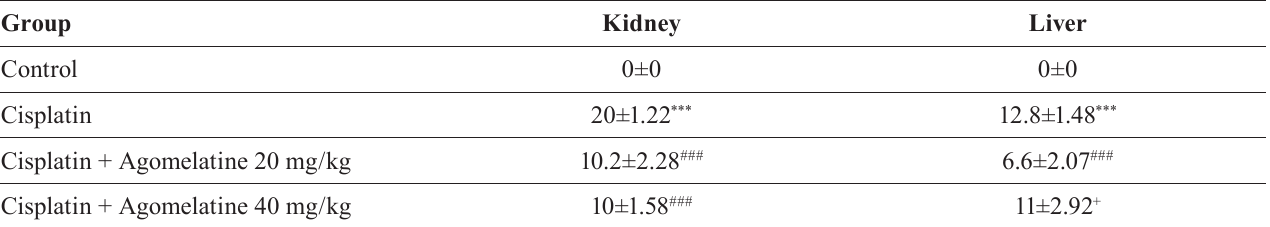
TABLE IV - Results of histopathological scores in all experimental groups in kidney and liver tissues